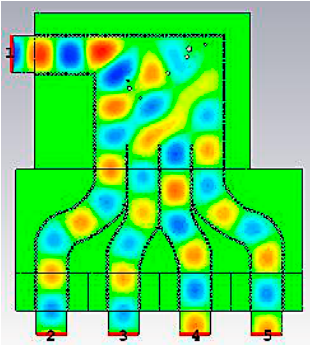
Figure 20. Electric field of four-way SIW power divider at 23 GHz.